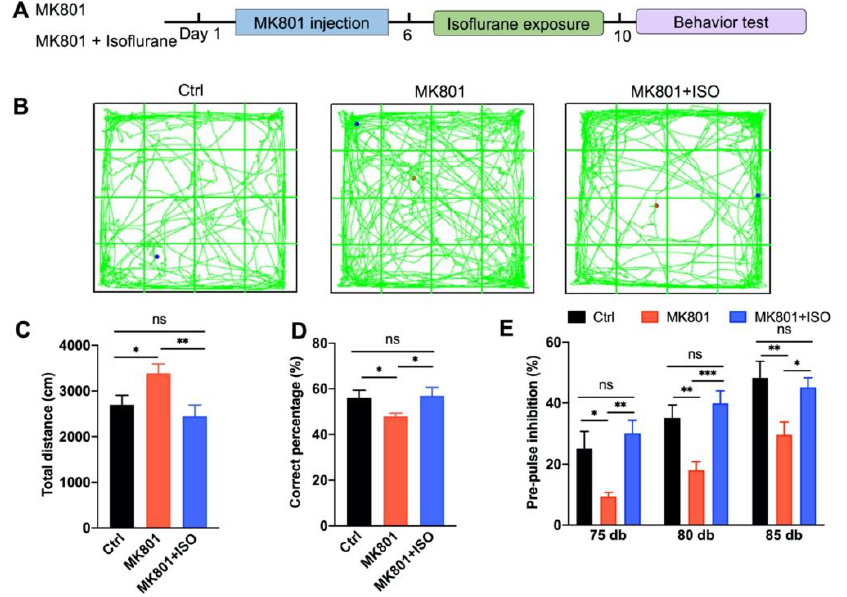
Figure 1. MK801-induced schizophrenia-related behavioral phenotypes are reversed by isoflurane. ( A ) Schematic diagram of the experimental design. After 5 days of MK801 injection and 5 days of isoflurane treatment, mice were subjected to behavioral tests. ( B ) Representative traces of mice in OFT. ( C ) Isoflurane treatment reversed the hyper-locomotion phenotype induced by MK801, revealed by OFT ( n = 10, 11, and 10 mice in Ctrl, MK801, and MK801+ISO groups, respectively. One-way ANOVA, F (2, 28) = 5.12, p = 0.01; post hoc test: Ctrl vs. MK801, p = 0.02; MK801 vs. MK801+ISO, p = 0.007; Ctrl vs. MK801+ISO, p = 0.46). ( D ) The working memory deficit induced by MK801 was attenuated by isoflurane exposure ( n = 9, 11, and 10 mice in Ctrl, MK801, and MK801+ISO groups, respectively. One-way ANOVA, F (2, 27) = 2.726, p = 0.01; post hoc test: Ctrl vs. MK801, p = 0.04; MK801 vs. MK801+ISO, p = 0.03; Ctrl vs. MK801+ISO, p = 0.84). ( E ) Isoflurane attenuated the pre-pulse inhibition deficit induced by MK801 ( n = 10, 14, and 12 mice in Ctrl, MK801, and MK801+ISO groups, respectively. Two-way ANOVA, F (2, 98) = 18.11, p < 0.0001; post hoc test: Ctrl vs. MK801, p = 0.004; MK801 vs. MK801+ISO, p = 0.01; Ctrl vs. MK801+ISO, p = 0.72). Data are represented as mean ± SEM, * p < 0.05, ** p < 0.01, *** p < 0.001, ns, not significant.